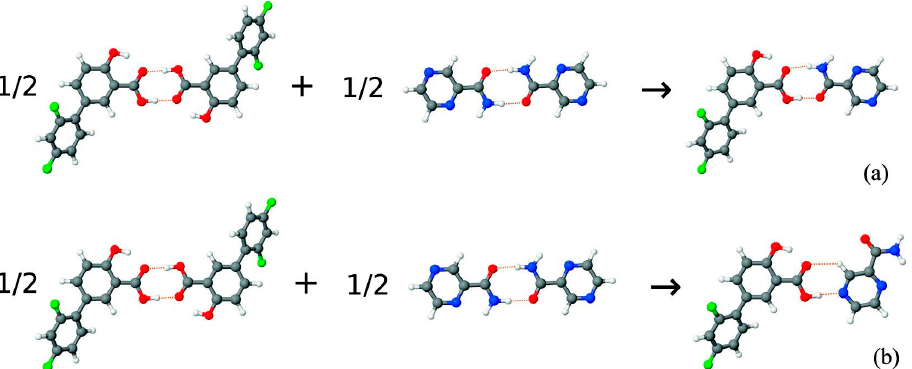
Figure 39. Probable hydrogen bond synthon ( a ) acid-amide and ( b ) acid-pyridine possible between the two drug molecules in 1:1 cocrystal. Adapted with permission from Crystal Growth & Design , 2011, 11, 4780–4788. Copyright 2011, American Chemical Society.